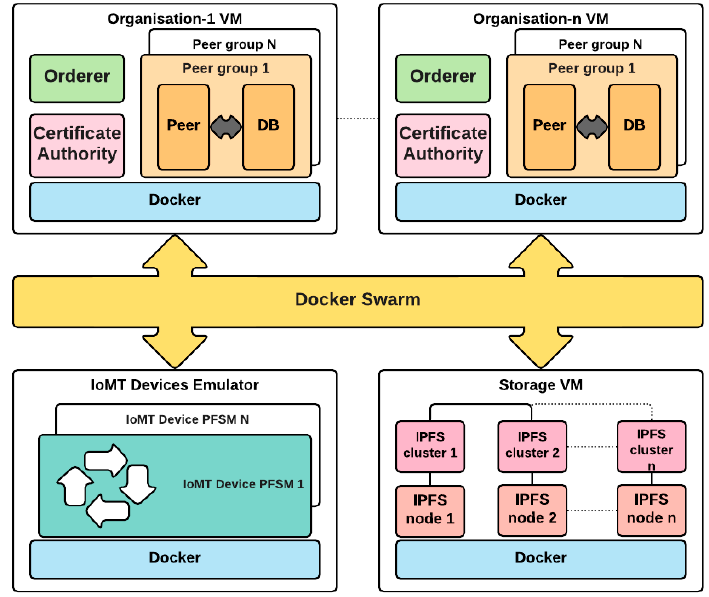
Figure 3. The architecture of the IoMT emulator.